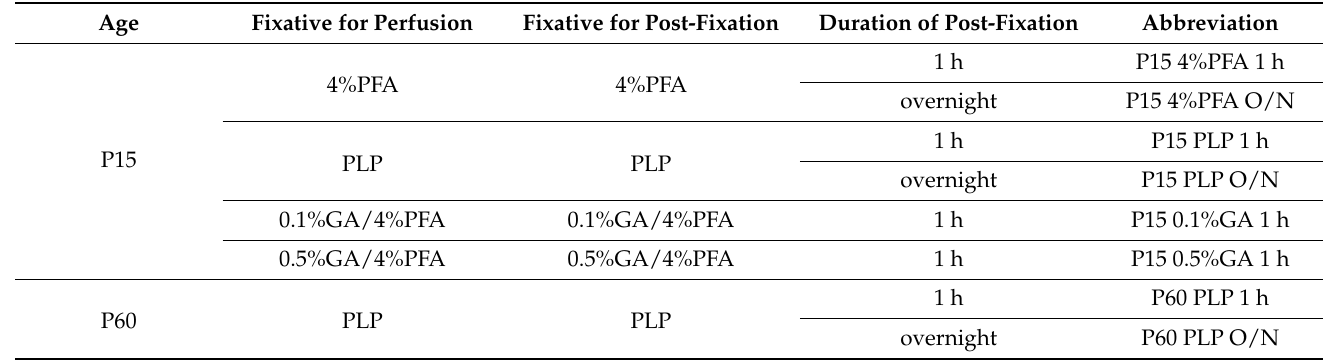
Table 1. Experimental